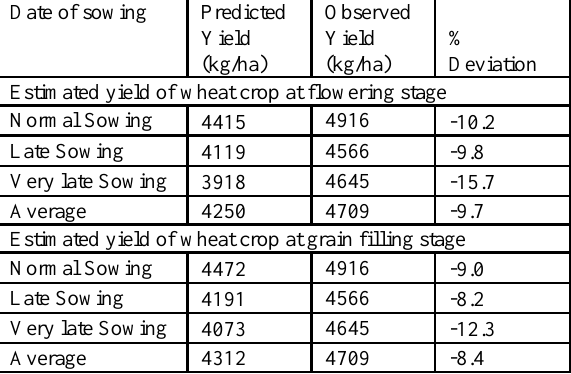
Table 3: Percentage deviation of observed yield from estimated yield of wheat crop by DSSAT model ( Rabi 2016-17) Weather during Rabi 2017-18 at IARI, New Delhi The maximum temperature during different